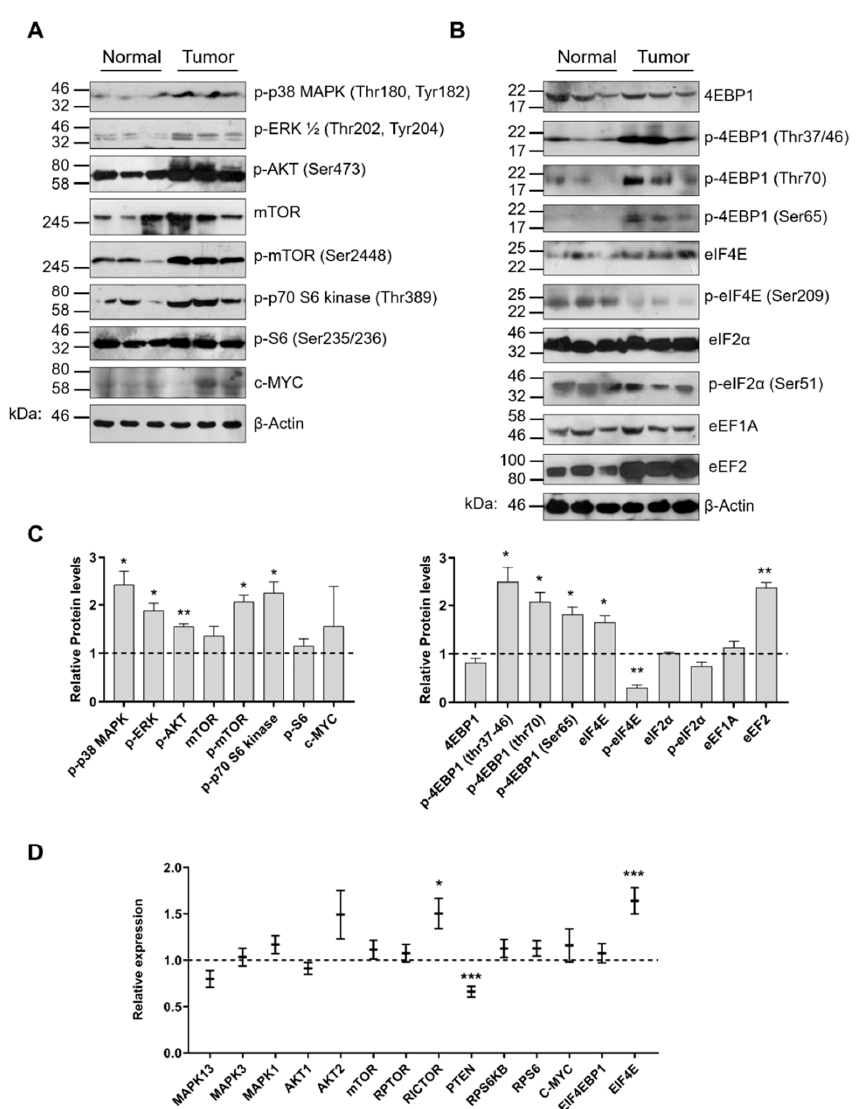
Figure 5. Alterations of PI3K / AKT / mTOR pathway, MAPK pathway, translation initiation and